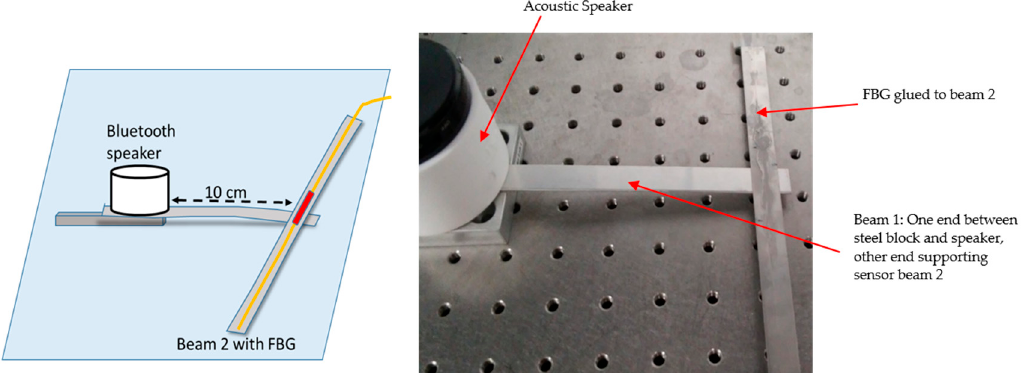
Figure 1. Experimental configuration with one beam bearing the FBG (fiber Bragg grating) and the other beam conducting the vibration from the acoustic source. Both ends of beam 2 are simply supported by the table. The schematic is shown on the